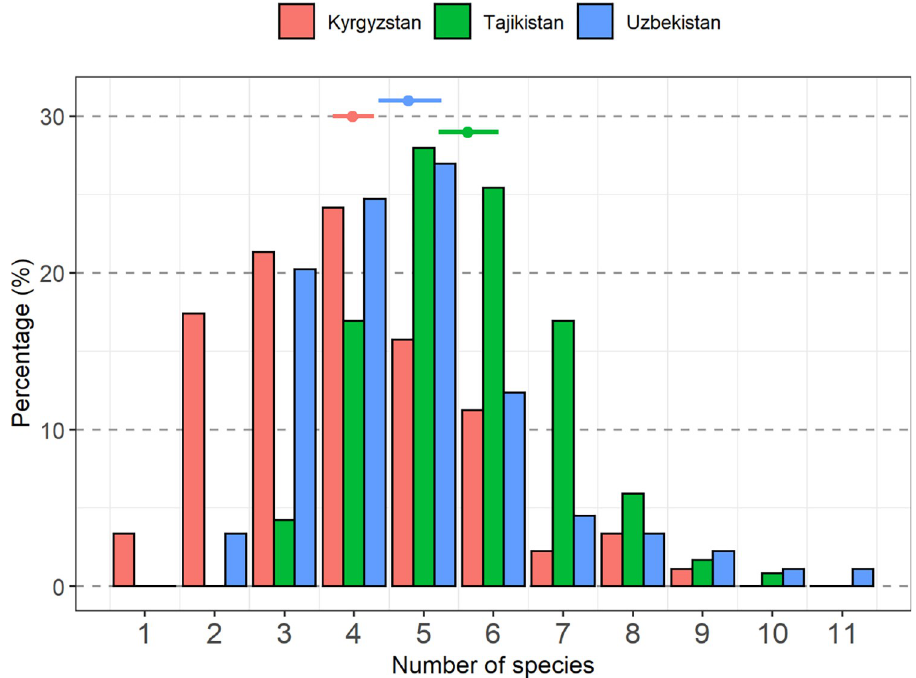
Fig 2. Proportion of participants (% per country) with a given number of plant species in their home garden.